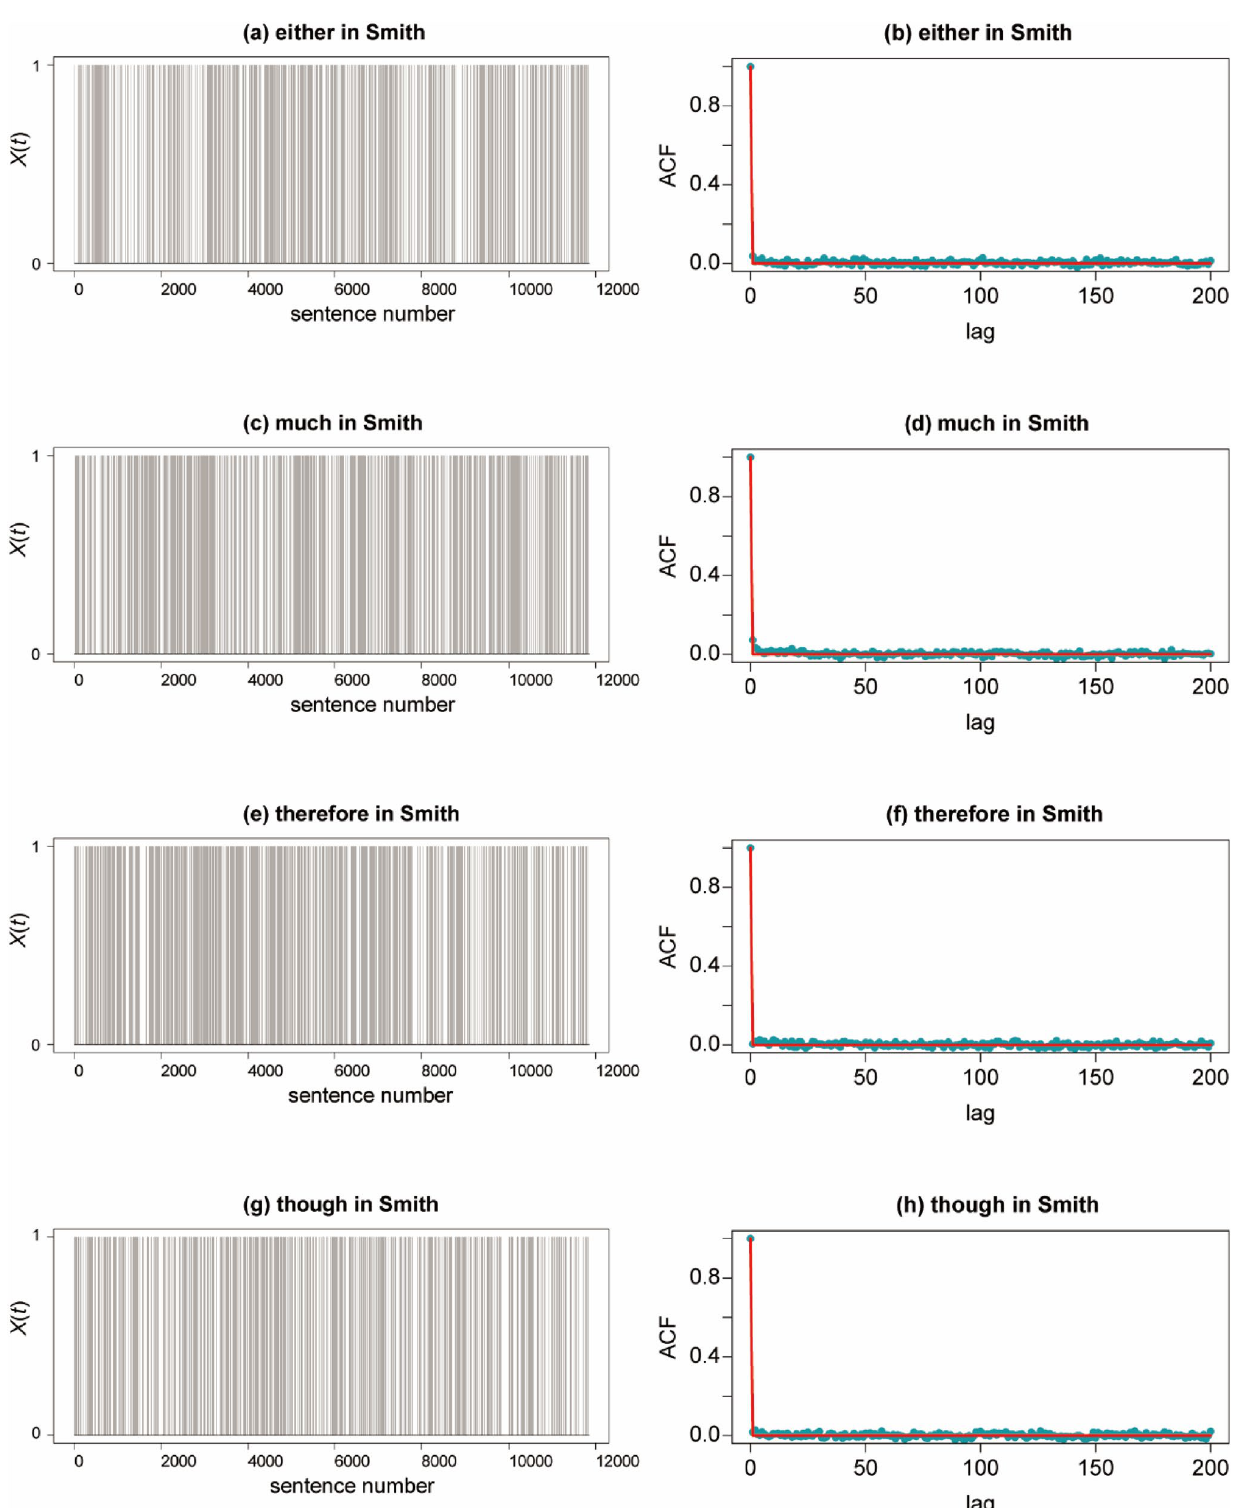
formly along texts (plots in the left column) and no types of correla- tions are seen (plots in the right column). Red lines in the plots of the right column show the step-down